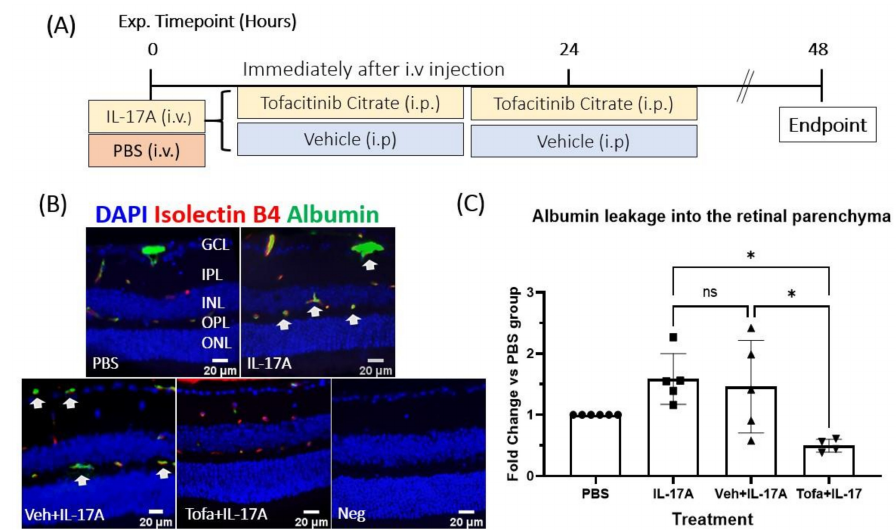
Figure 6. Tofacitinib Citrate ameliorates IL-17A-induced leakage in wild-type mice. C57BL/6J mice were treated with or without Tofacitinib Citrate immediately after IL-17A or vehicle (PBS) intravenous (iv) injection and were treated with Tofacitinib/vehicle again 24 h later. Retinae were collected 48 h later and processed for immunostaining of albumin and isolectin B4. ( A ) Schematic of experimental design. ( B ) Representative images showing albumin (green) and isolectin B4 (red, marker of vascular endothelial cells). Albumin outside the isolectin B4 + area was considered indicative of vascular leakage. White arrows: albumin leakage. ( C ) Quantification of albumin extravasation. Two or three images from the central retina were quantified per animal. Values were normalized to PBS control on the same slide. Mean ± SD; n ≥ 5 animals per group; ROUT outliers test 2% was used to remove outliers. Cleaned data were compared by using One-Way ANOVA with Tukey’s multiple comparisons test, * p < 0.05; ns: no statistical